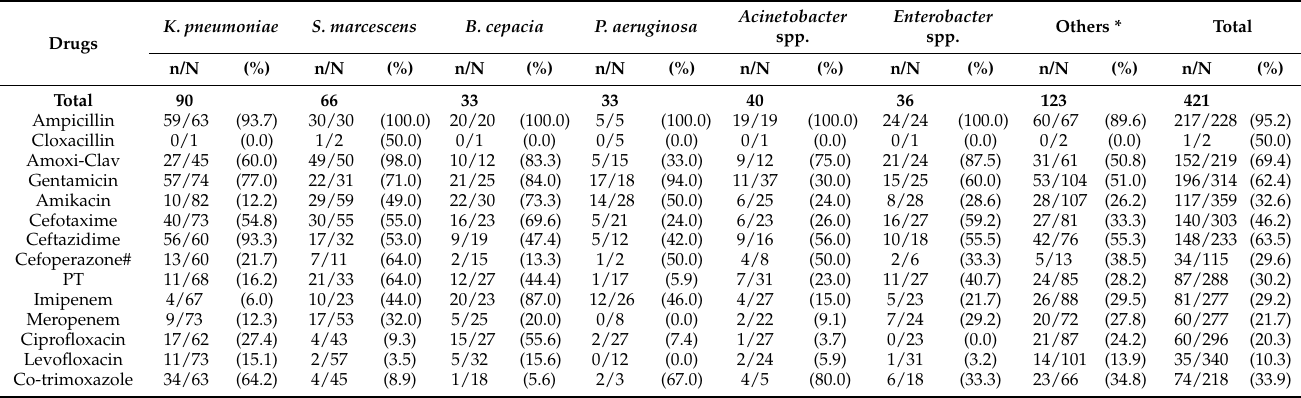
Table 5. Gram-negative isolates and antimicrobial resistance pattern among neonates with bacteriologically confirmed sepsis admitted to the NICU of two tertiary care hospitals in Yangon, Myanmar, January 2017 to December